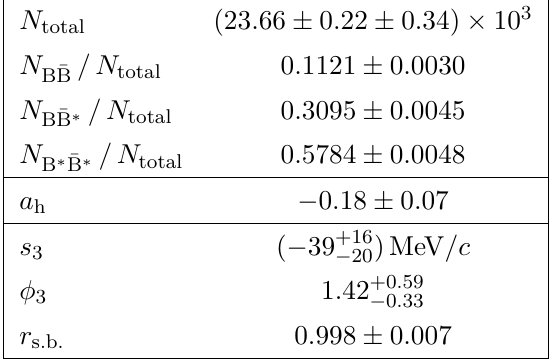
Table 3 . Results of the fit to the M bc distribution at Υ(5 S ) . The errors are statistical. fit function beyond the fit interval and indeed find an excess of events near the